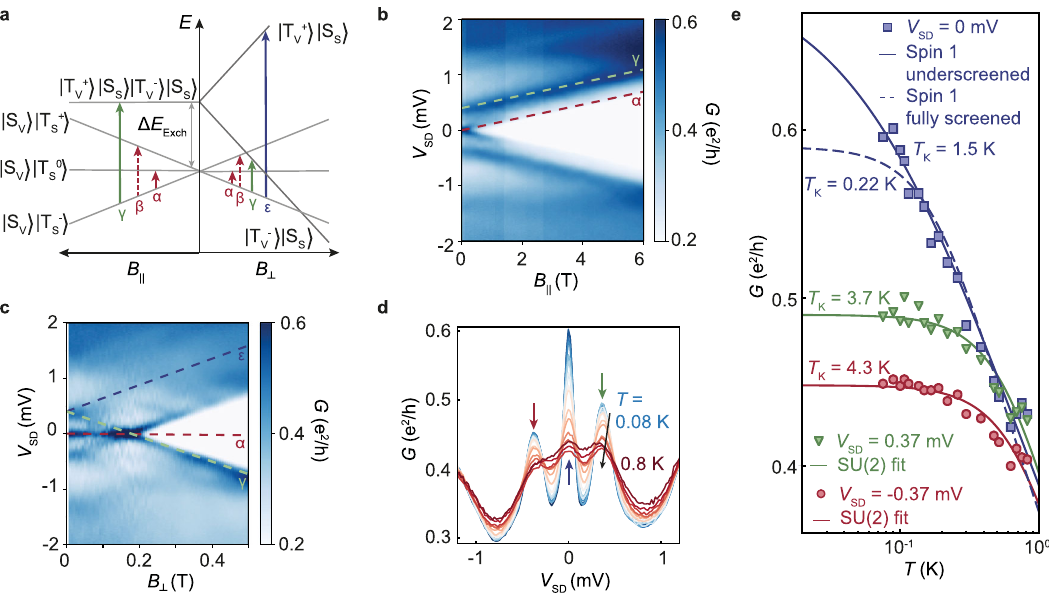
Fig. 3 Triplet Kondo effect for N = 2 h. a Expected level splittings in magnetic fi eld applieds parallel and perpendicular to the sample with exchange energy Δ E fi eld. A splitting of the Kondo resonance with the spin g -factor of two and an energy increase of the Exch . b Kondo resonance in parallel magnetic resonances at fi nite bias is observed. c Splitting of the Kondo resonance in perpendicular magnetic fi eld. The resonances at fi nite bias split with a valley g -factor of 40, while the Kondo resonance is not affected by the magnetic fi eld up to 0.2 T. d Conductance around V SD = 0 at B = 0 for different temperatures. A Kondo resonance at V SD = 0 and two fi nite-bias resonances at V SD = ± 0.37 mV are observed. e Temperature dependence of the Kondo resonance at V SD = 0 and the fi nit-bias resonances at V SD = ± 0.37 meV. The temperature dependence can be described by a spin-1 Kondo model with a Kondo temperature of 1.5 K. The fi nite-bias resonances are fi tted with a SU(2) Kondo model and Kondo temperatures of about 4